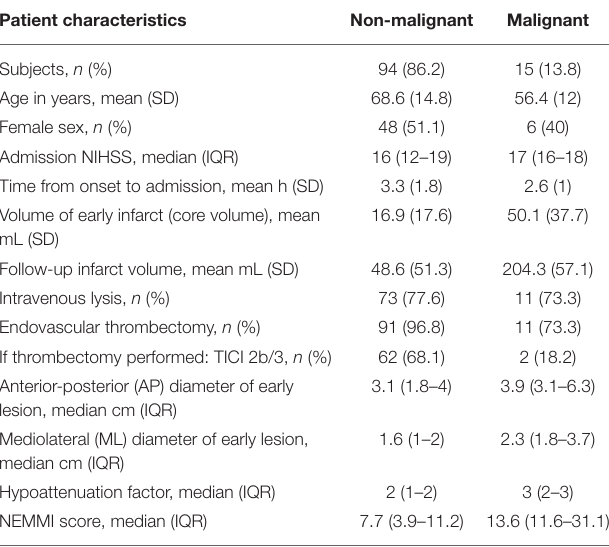
TABLE 1 | Patient characteristics stratified by malignant and non-malignant